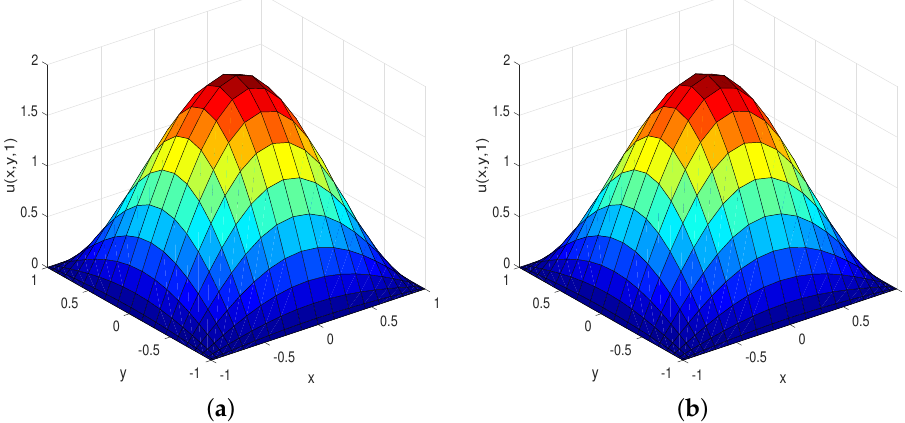
Figure 2. The velocity distribution of the exact solution and the numerical solution with τ = 0.01, N x = N y = 20, α = 0.3, β = 0.7, T = 1. ( a ) Exact result; ( b ) numerical result.